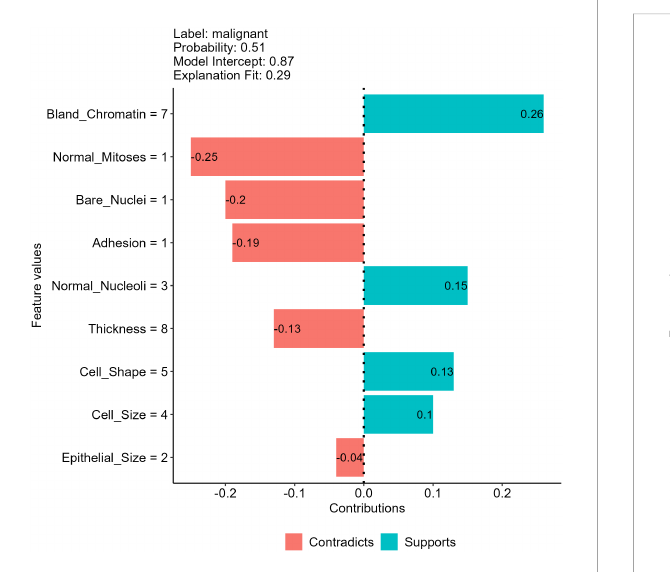
FIGURE 7 Feature effects on neural network (NNET) model prediction for the breast mass sample randomly selected using a local surrogate model approach.